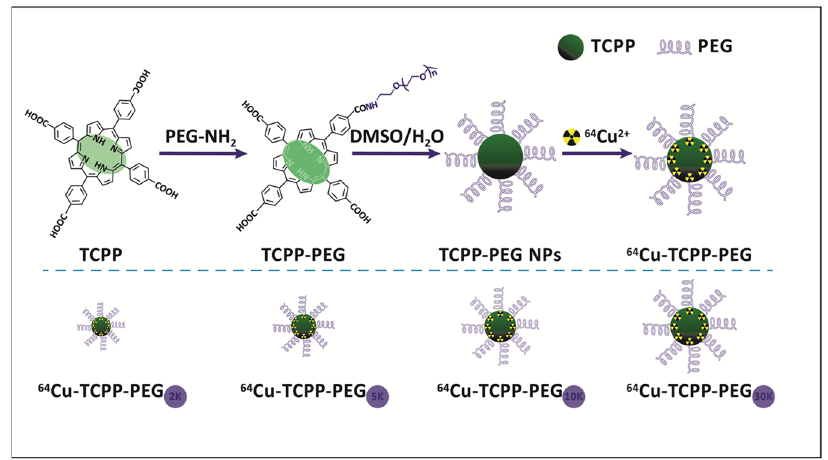
Figure 4. Synthesis of TCPP–porphyrin nanoparticles with various molecular weights of PEG chains. Reprinted with permission from [67]. 2016. Copyright Elsevier.